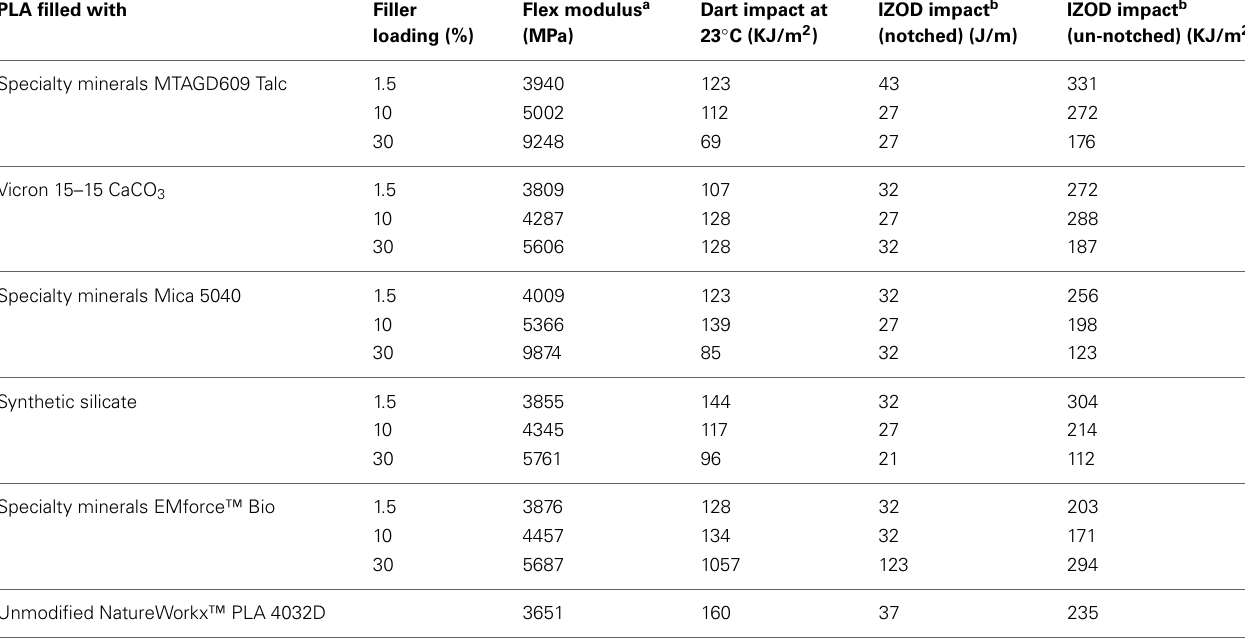
Table 13 | Mechanical properties of some fillers blended with PLA (http://www.natureworksllc.com/ ∼ /media/Technical_Resources/